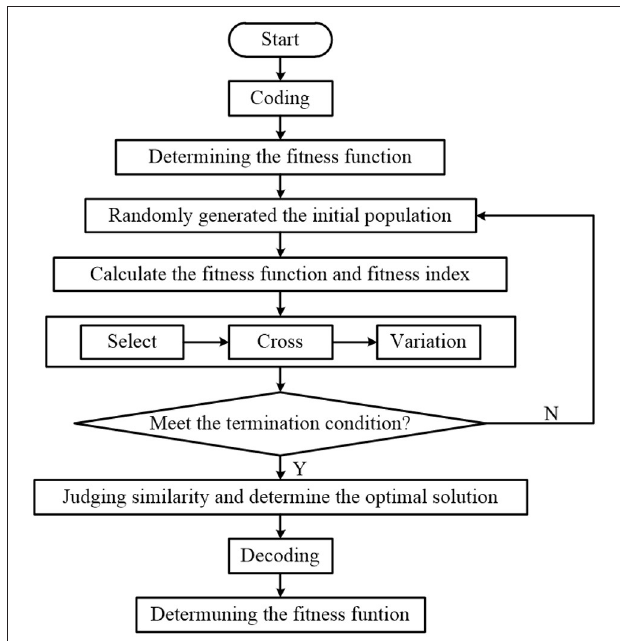
FIGURE 3 | Flowchart of seedling image segmentation.